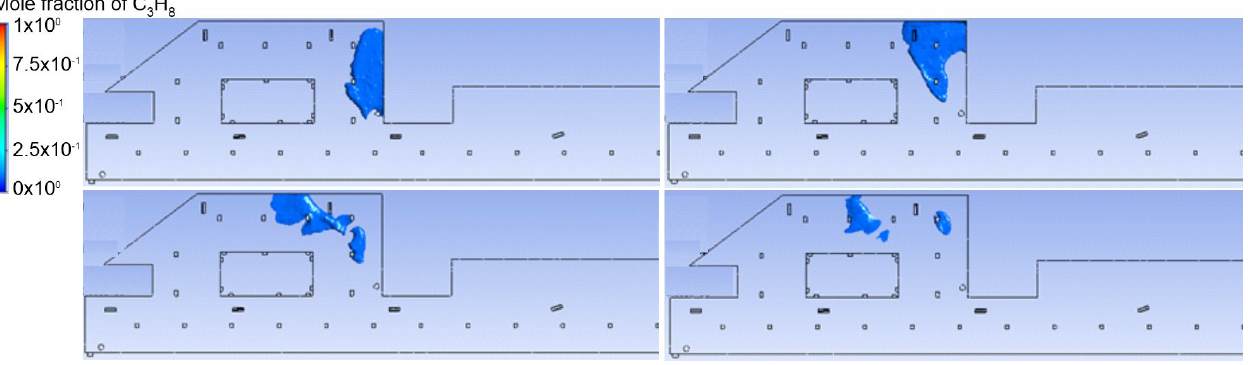
Figure 15. Lower explosive limit of LPG distribution in an underground garage after gas dispersion for A source for different time steps of 15 s, 35 s, 55 s and 70 s.